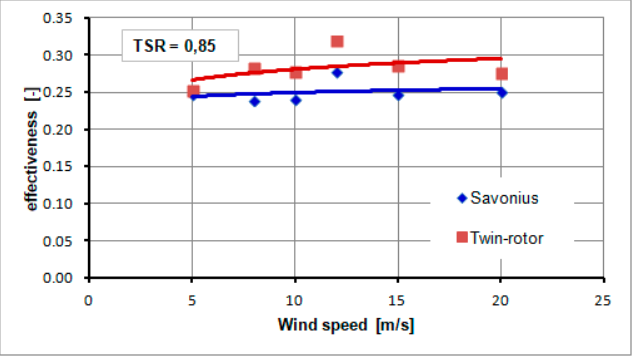
Figure 11. Effectiveness of Savonius and Twin-Rotor as a function of wind speed. Figure 11. E ff ectiveness of Savonius and Twin-Rotor as a function of wind